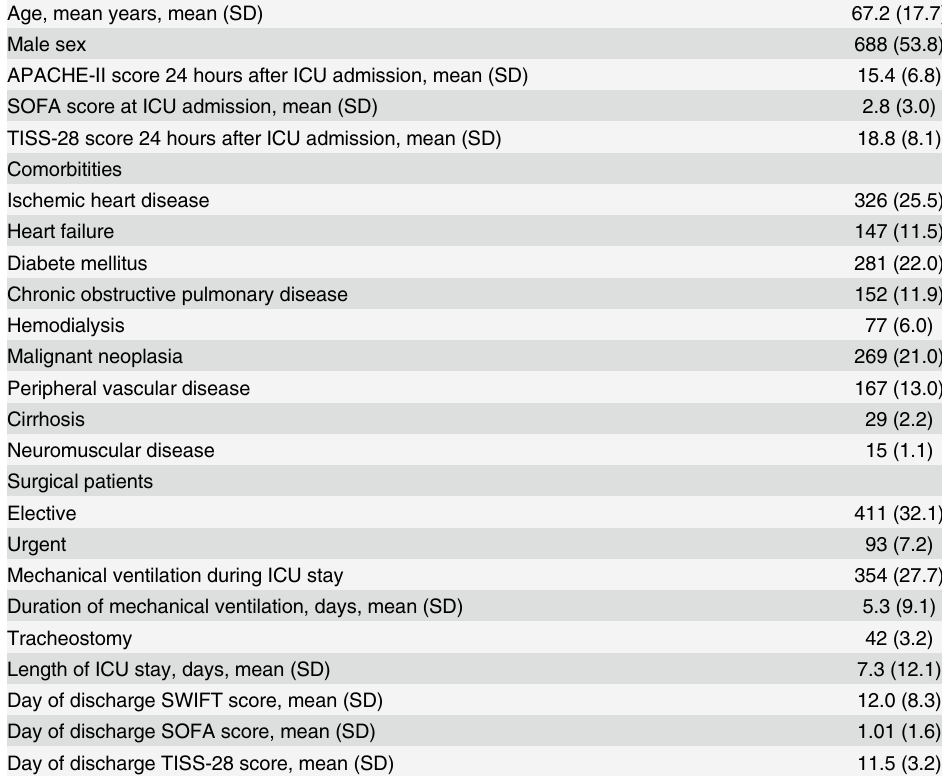
Table 4. Characteristics of 1,277 adult patients discharged from